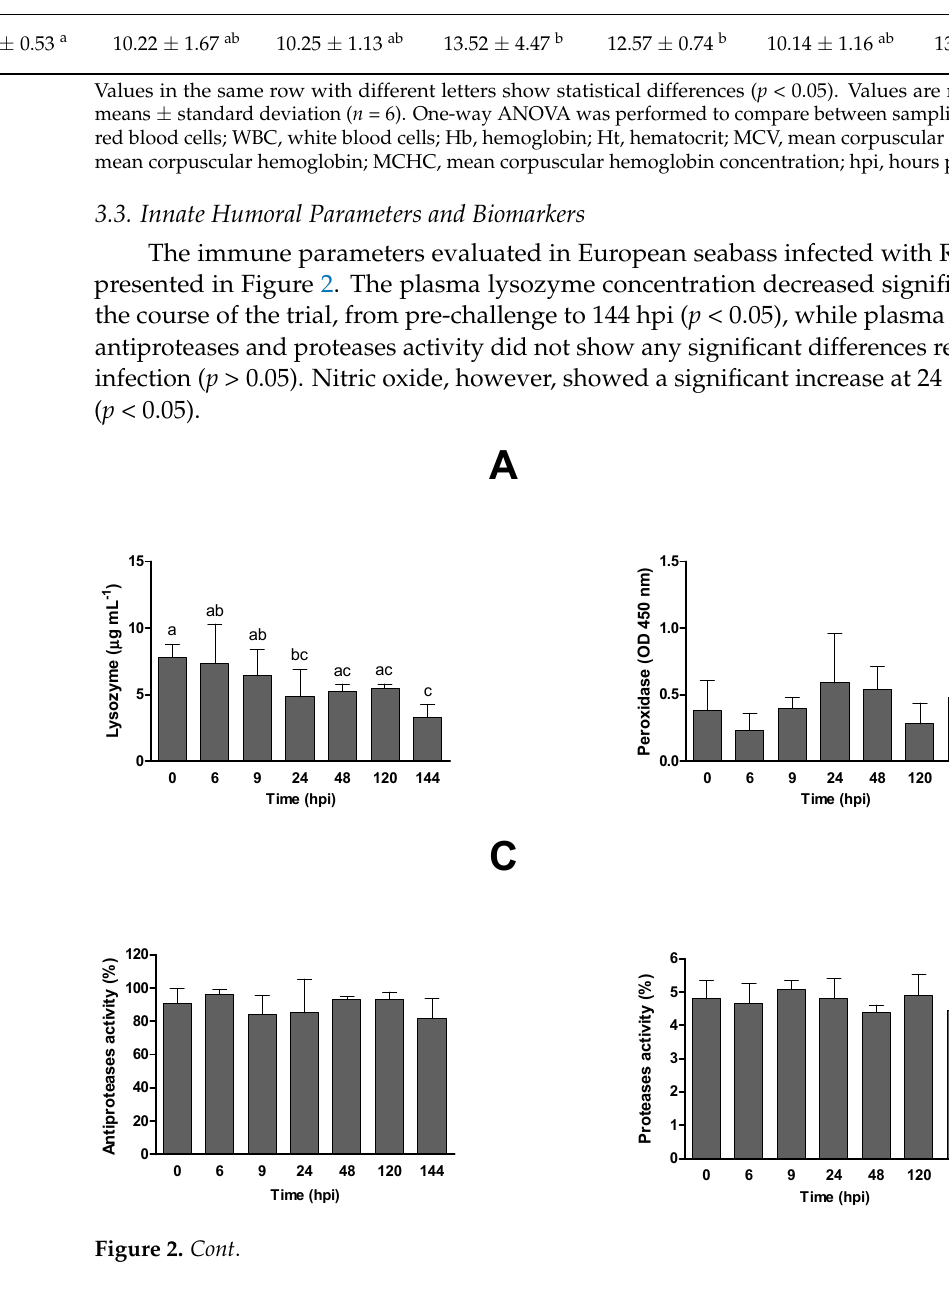
Figure 2. Innate humoral parameters of European seabass ( Dicentrarchus labrax ) infected with RGNNV at different hours post-infection (hpi): ( A ) lysozyme concentration, ( B ) peroxidase activity, ( C ) antiproteases activity, ( D ) proteases activity and ( E ) nitric oxide are presented as mean ± SD ( n = 6). One-way ANOVA was used to compare between different sampling times. Different letters show statistically significant differences between sampling times ( p < 0.05).